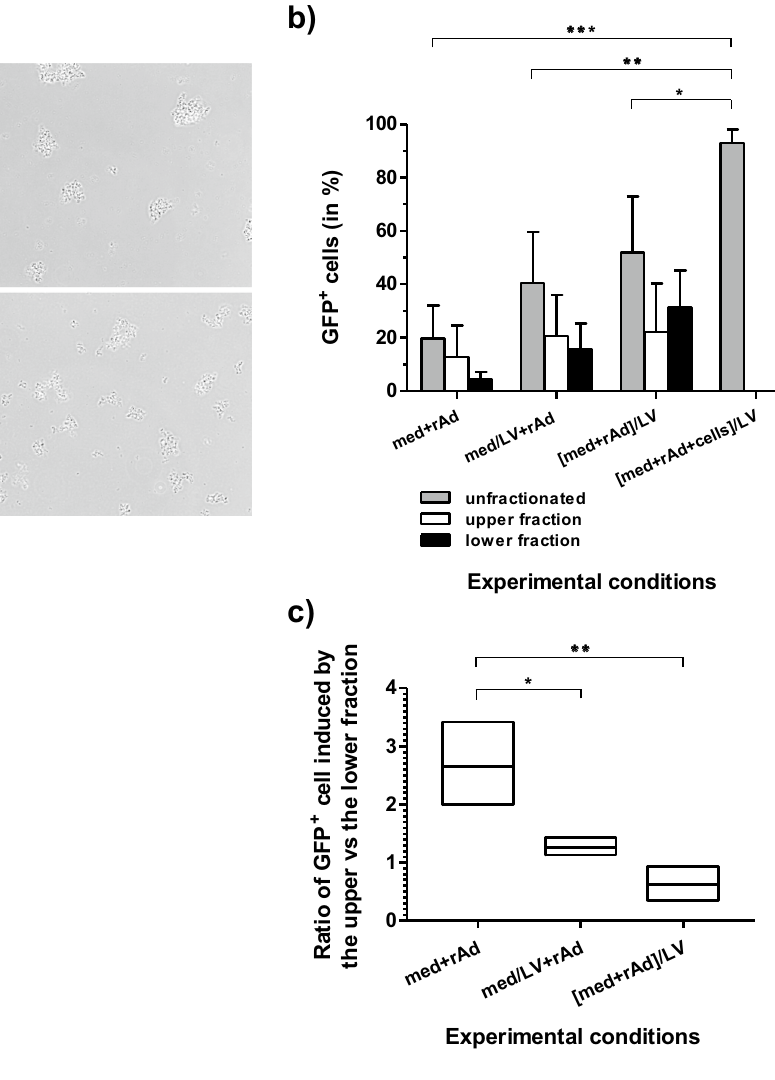
Figure 4. Observation of aggregated particles after LV pulse application and their role in the enhancement of GFP conversion in infected L929 cells. ( a ) Aggregated particle observation by optical microscopy (magnification: × 200), after application of twenty LV pulses on aliquots of three different solutions: (1) negative control (S-MEM unpulsed), (2) S-MEM pulsed, (3) PBS pulsed, (4) Hepes/NaCl pulsed. Size scale corresponding to the black bar is 80 µm. Photo editing was realized with Gimp 2.1 software. ( b ) Role of aggregated particles in the enhancement of GFP gene expression. L929 cells were infected with rAd (final MOI of 10 4 vp/cell) using three types of inoculum: (1) viral suspension made in crude culture medium without any electric pulse (med + rAd); (2) viral suspension made using culture medium pulsed prior to virus mixing (med/ LV + rAd); (3) viral suspension made in crude culture medium but pulsed after virus mixing ([med + rAd]/ LV); for the last experimental condition, LV pulses were directly applied on cells, already mixed with viral suspension ([med + rAd + cells]/LV). In addition, for the first three experimental conditions, the viral suspension was either left 10 min at 4 °C (unfractionated inoculum indicated in grey) or subjected to a short centrifugation (300× g , 10 min, 4 °C) in Eppendorf tubes, yielding a upper (40 µl) and a lower (10 µl) fractions (indicated in white and black, respectively). Each fraction was then separately added to L929 target cells and GFP cell conversion was assessed by flow cytometry 24 h post treatment. UP unpulsed, LV application of low voltage pulses, med medium, rAd recombinant adenovirus. Data are presented as bar chart, with means ± SD (n = 3, except ultimate condition where n = 4). Statistical significances: * p < 0.05, ** p < 0.01, and *** p < 0.001 stand for comparisons between experimental conditions (without fractionation) indicated by the brackets on the graph (one-way ANOVA with Bonferroni’s post-test). ( c ) The ratios of GFP cell conversion induced by the upper versus the lower fraction are presented for the first three experimental conditions as vertical boxes (minimum to maximum value), with central line indicating the mean and Y-axis indicating the ratio values. Statistical significances: * p < 0.05 and ** p < 0.01 stand for the ratio comparisons indicated by the brackets on the graph (one-way ANOVA with Bonferroni’s